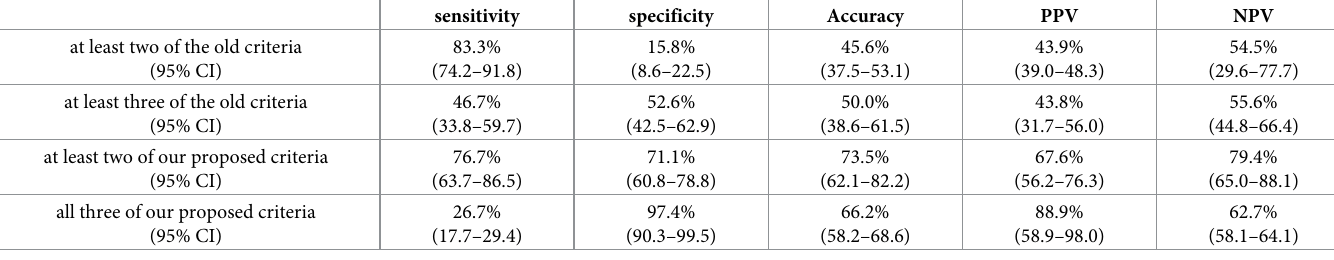
Table 4. Accuracy of the previously used criteria and our proposed